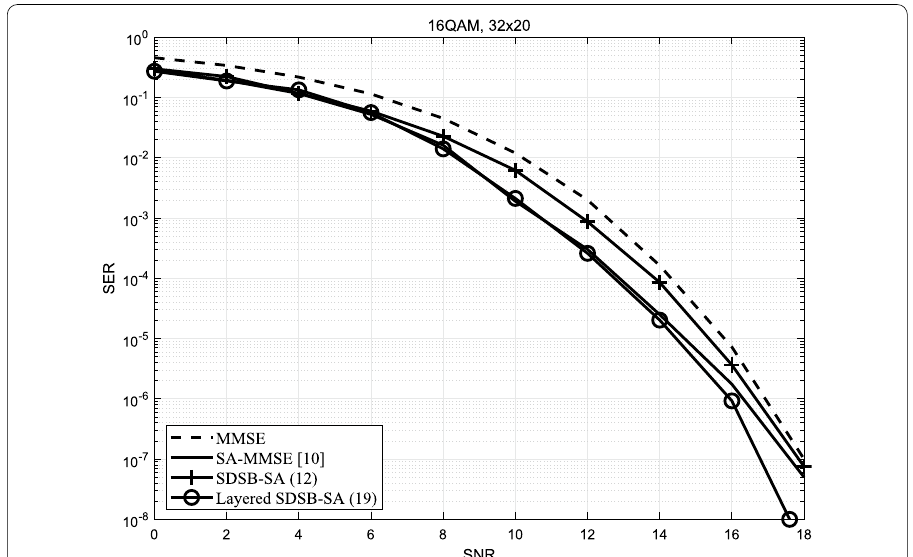
Fig. 5 Performance comparison of MMSE, SA-MMSE and Layered SDSB-SA detector for 32 × 20 MIMO system,